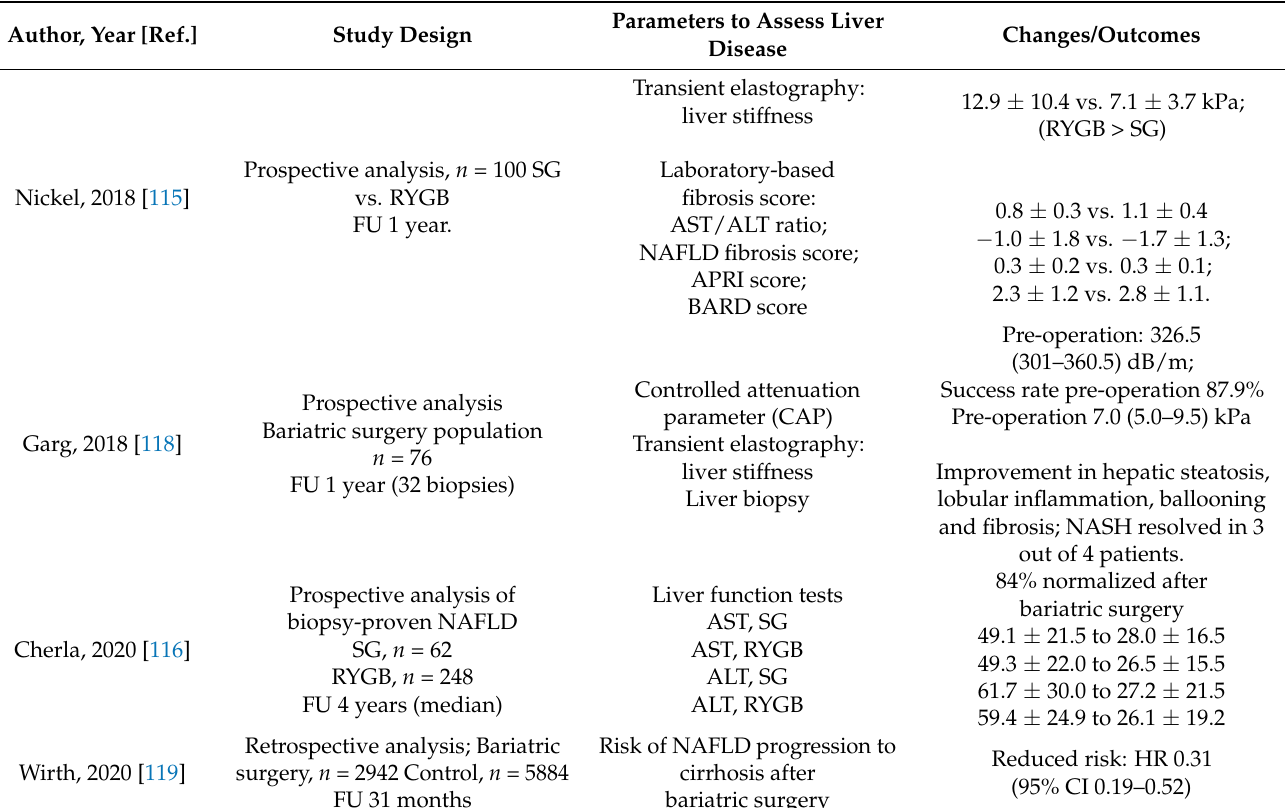
Table 3. Bariatric surgery and